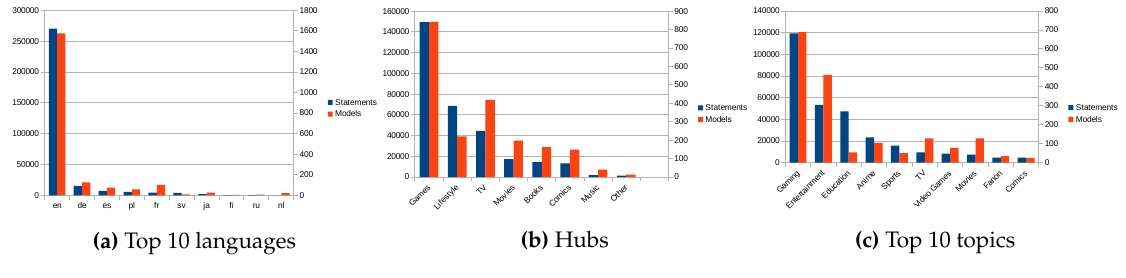
Figure 10. Distribution of learned models and extracted relations by language, hub, and